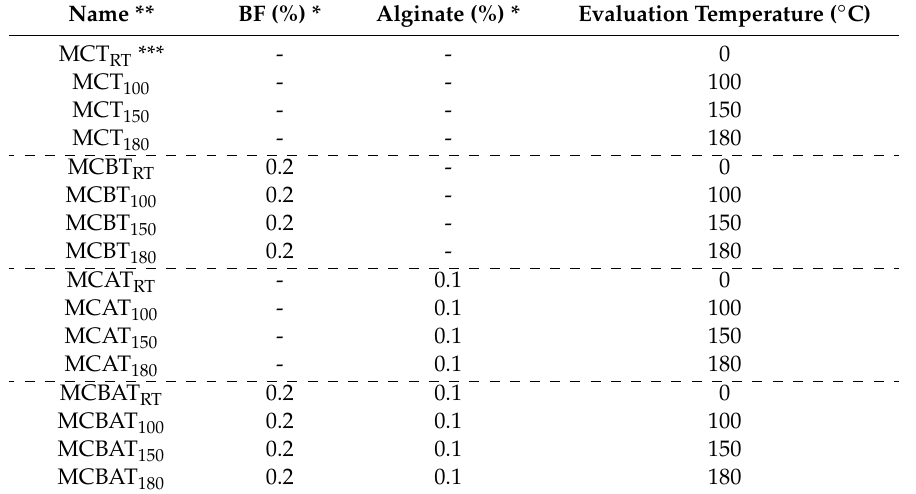
Table 6. Compressive strength of primary tests.